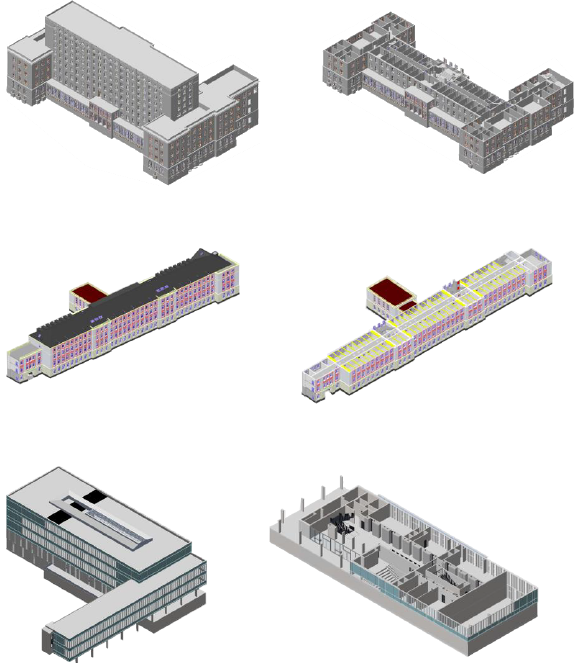
Figure 1. Campus buildings in IFC: Z-, S- and N-building (top to bottom) with external (left) and internal (right) isometric